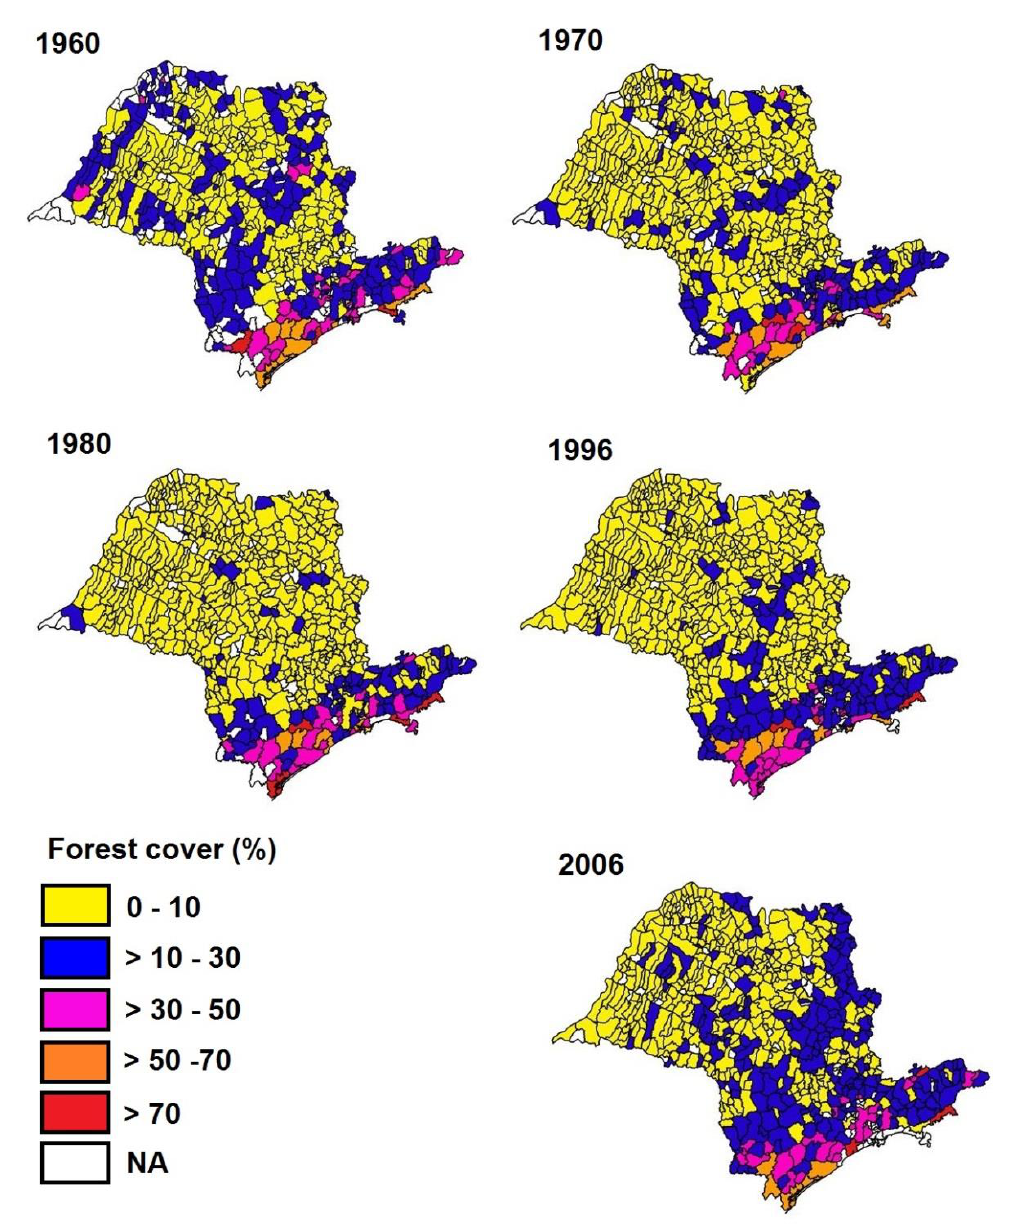
FIGURE A1.1 Percentage of forest cover at the municipality-scale for São Paulo state calculated for the years 1960, 1970, 1980, 1996 and 2006. Municipality boundaries are shown in black. (NA) Missing